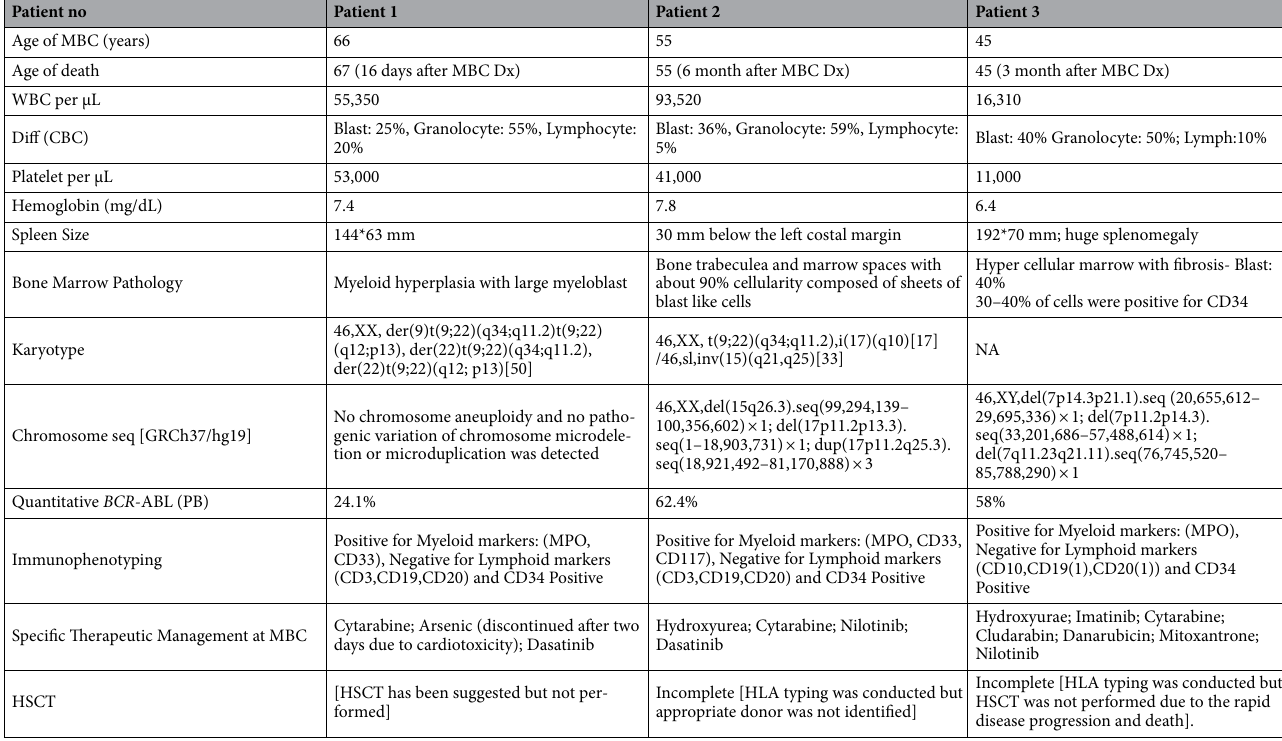
Table 2. Clinical and laboratory findings for the CML patients in MBC phase. Dx diagnosis, NA not available, MBC myeloid blast crisis, HSCT hematopoietic stem cell